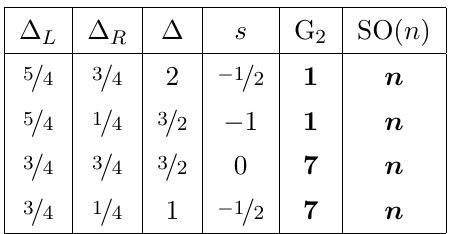
= (7 ; 1) supersymmetry. The gauge group N